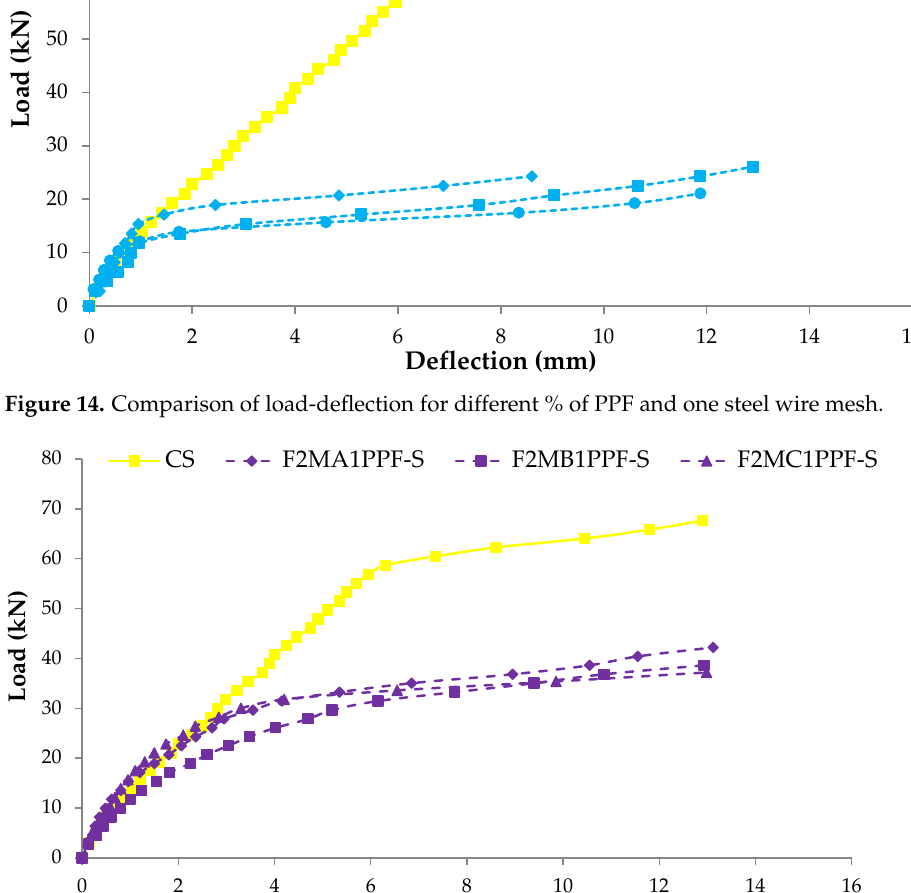
Figure 15. Comparison of load-deflection for different % of PPF and two steel wire mesh.